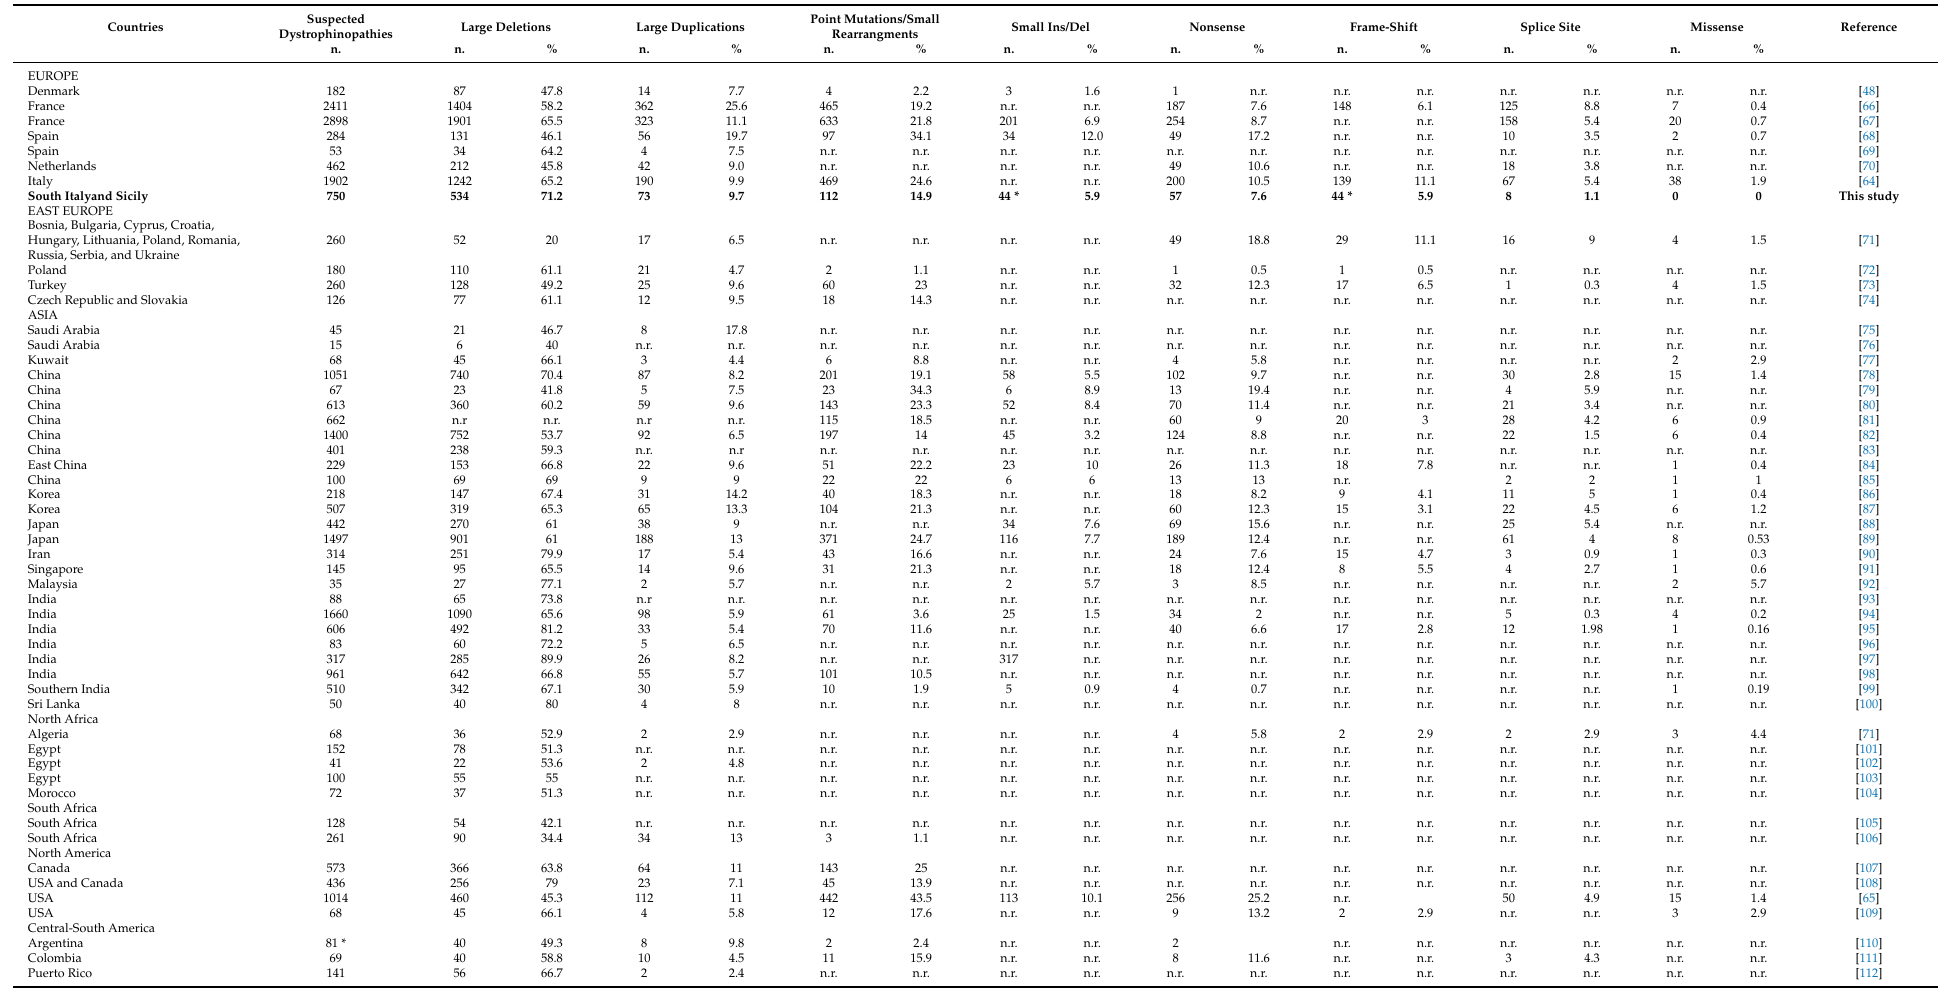
Table 1. Distribution of dystrophin gene pathogenic variants in the different countries of the world, based on their geographical area. The countries were subdivided into seven macro-areas: Western Europe, East Europe, Asia, North Africa, South Africa, North America, and Central-South America. Countries Suspected Dystrophinopathies LargeDeletions LargeDuplications PointMutations/Small Rearrangments